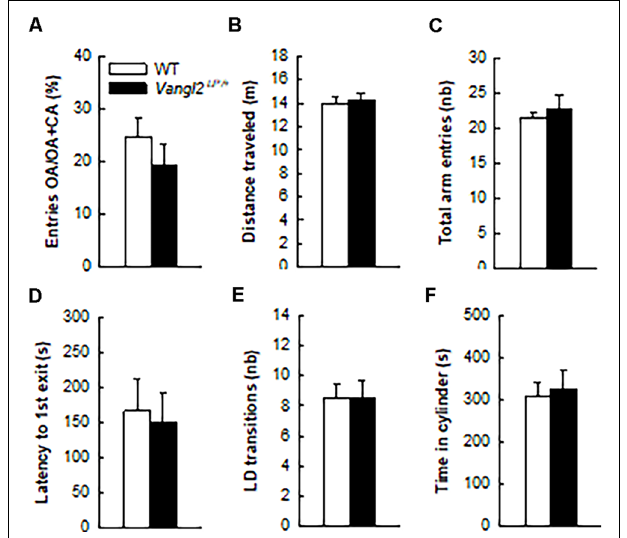
FIGURE 3 | Vangl2 lp mutation does not affect anxiety-related phenotype. Anxiety-like responses were measured in the elevated plus maze (A–C) and in the light/dark emergence task (D–F) . White bars, WT n = 21 mice; Black bars, Vangl2 Lp/+ n = 16